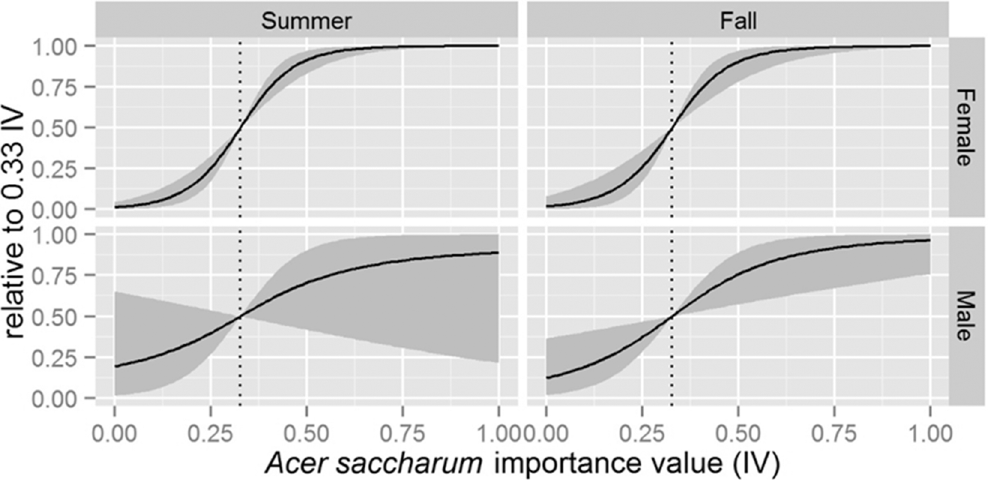
Fig 4. Predicted probability of selecting a roost as a function of Acer saccharum importance value for male and female Indiana bats ( Myotis sodalis ) in summer and fall months in Fort Drum, NY, USA between 2007 – 2011. Solid lines indicate mean posterior probability of use and gray ribbons represent the limits of 95% credible intervals. Each panel assumes bats are faced with a choice of 2 potential roosts: one fixed at the observed mean Acer saccharum importance value (vertical dashed line) and the other represented by the value of the x -axis. All other variables are assumed constant.